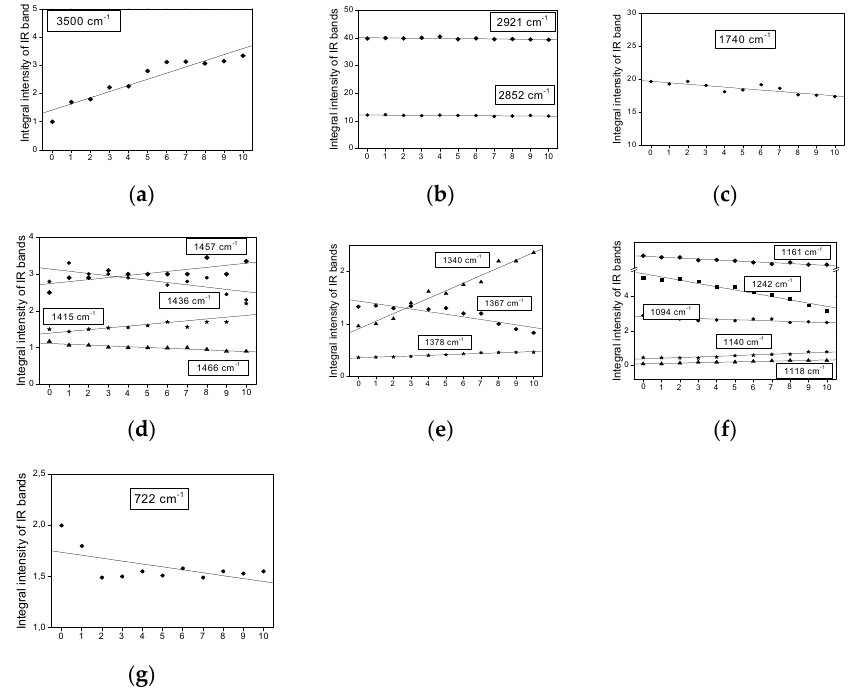
Figure 5. The dependence of the band intensity on heating time, as observed in the IR spectra of the rice bran oil at: ( a ) 3500, ( b ) 2921 and 2852, ( c ) 1740, ( d ) 1466, 1457, 1436 and 1415, ( e ) 1378, 1367 and 1340, ( f ) 1242, 1161, 1140, 1118 and 1094, and ( g ) 722 cm − 1 .